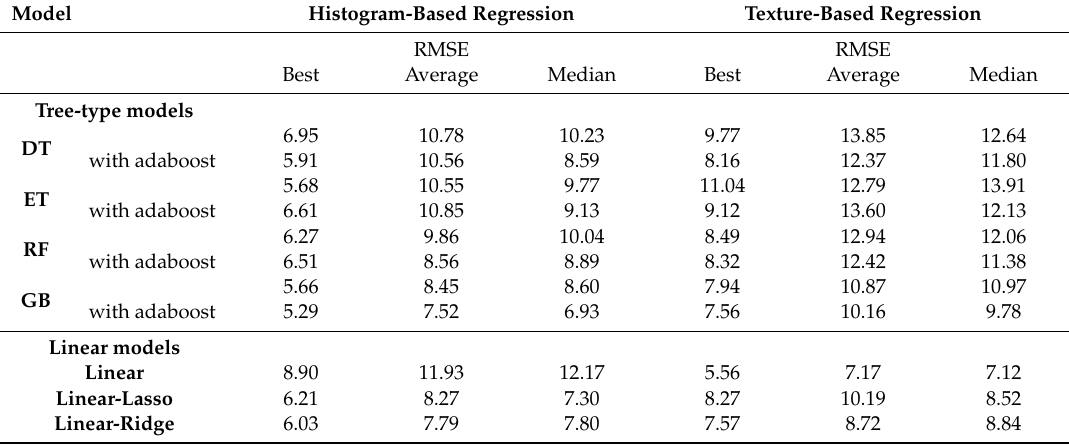
Table 3. Overview of average predictive accuracy as RMSE of the predicted fuel quality for the di ff erent methods and